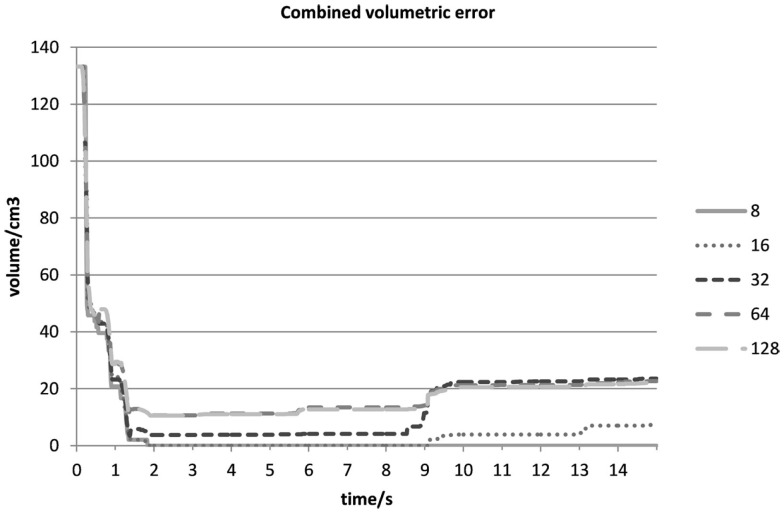
Total volumetric difference (cm3) between initial and final shape-optimized CT over time (s) for different voxel resolutions in Experiment 1.